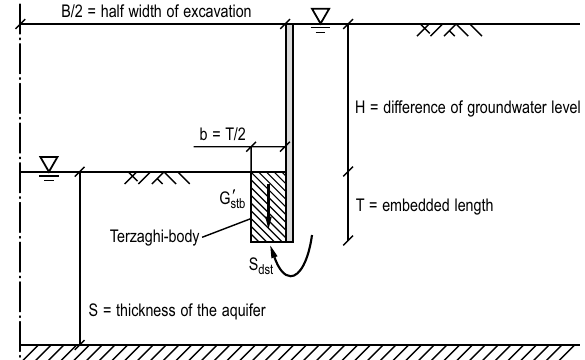
Fig. 2. Two-dimensional system including the